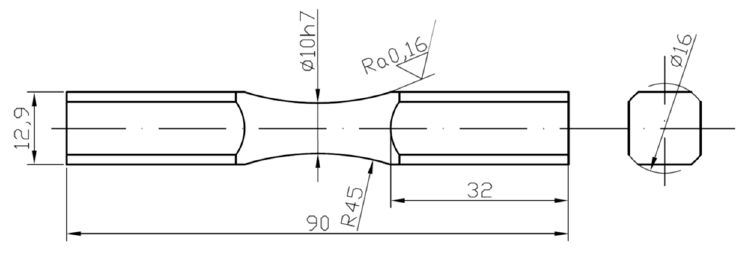
Figure 4. The specimen’s geometry for fatigue testing, in mm.